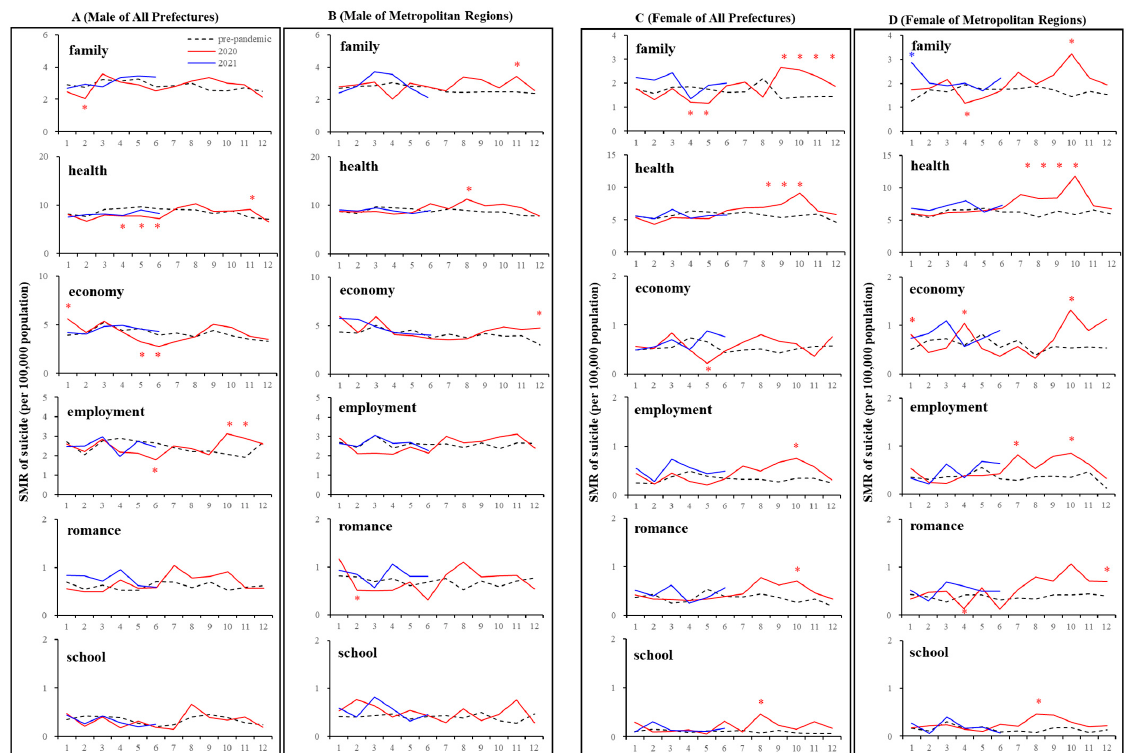
Figure 10. Temporal fluctuations in monthly SMR-S disaggregated by gender, suicidal reason, and regional factors during the COVID-19 pandemic period (2020–2021) compared to the average SMR-S of the same month during the pre-pandemic period (2017–2019). Dotted black, red, and blue lines indicate the average of SMR-S for ( A ) males from all 47 prefectures, ( B ) males from metropolitan regions, ( C ) females from all 47 prefectures, and (D) females from metropolitan regions. Ordinates indicate the SMR-S (per 100,000 people), and abscissas indicate the month. * p < 0.05, significant change using a linear mixed-effects model with Tukey’s multiple comparison. Red and blue asterisks indicate significant changes in SMR-S in 2020 and 2021, respectively, compared to the average SMR-S of the same month during the pre-pandemic period.